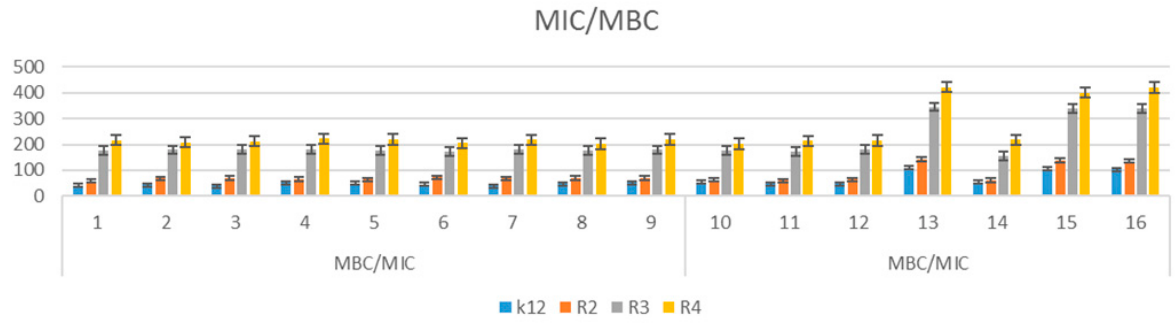
Figure 4. Minimum bactericidal concentration (MBC) of the phosphonate derivatives. The x -axis features compounds 1 – 16 used sequentially. The y -axis shows the MIC value in µg/mL − 1 . Investi- gated strains of E. coli K12 as control (blue), R2 strains (orange), R3 strains (grey), and R4 strains (yellow). The order in which the compounds were applied to the plate is shown in Supplementary Materials Figure S1.